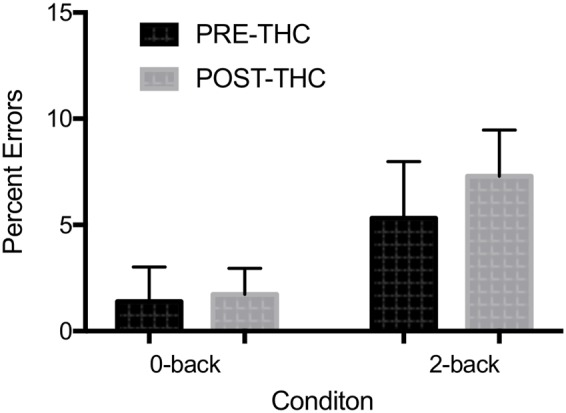
Mean percent errors during n-back working memory (WM) task. A robust main effect of memory-load was found. No significant interactions between memory-load type and drug treatment condition were found. Error bars represent standard deviations.